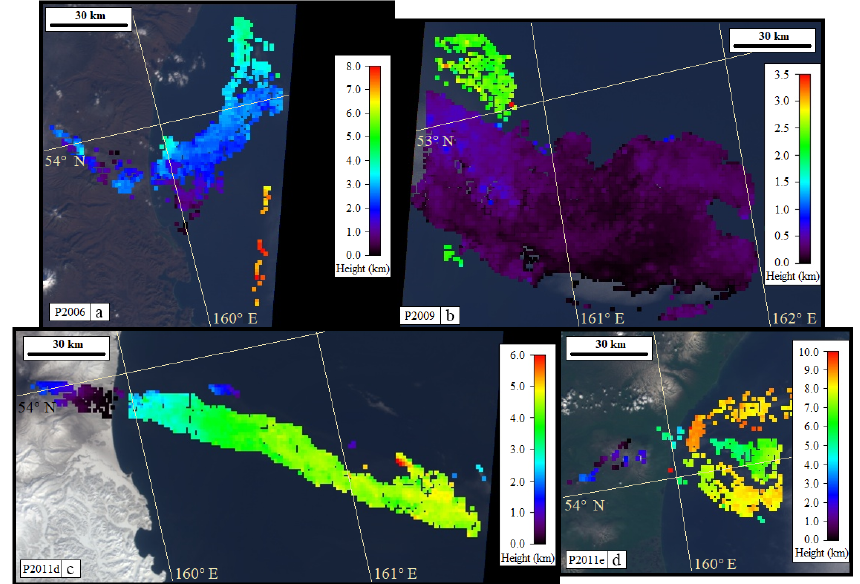
Figure 3. MISR stereo height retrieval maps derived using the MISR INteractive eXplorer (MINX). Class 2 plumes (moderate MeNspWab) emitted from Karymsky volcano on (a) 23 October 2006 (orbit: 36416; path: 97; blocks: 47–48), (b) 12 July 2011 (orbit: 61507; path: 97; blocks: 47–48), (c) 7 May 2011 (orbit: 60546; path: 99; blocks: 47–48) and (d) 26 April 2009 (orbit: 49755; path: 96; blocks: 48–49). Note that the elevation scales vary from panel to panel.